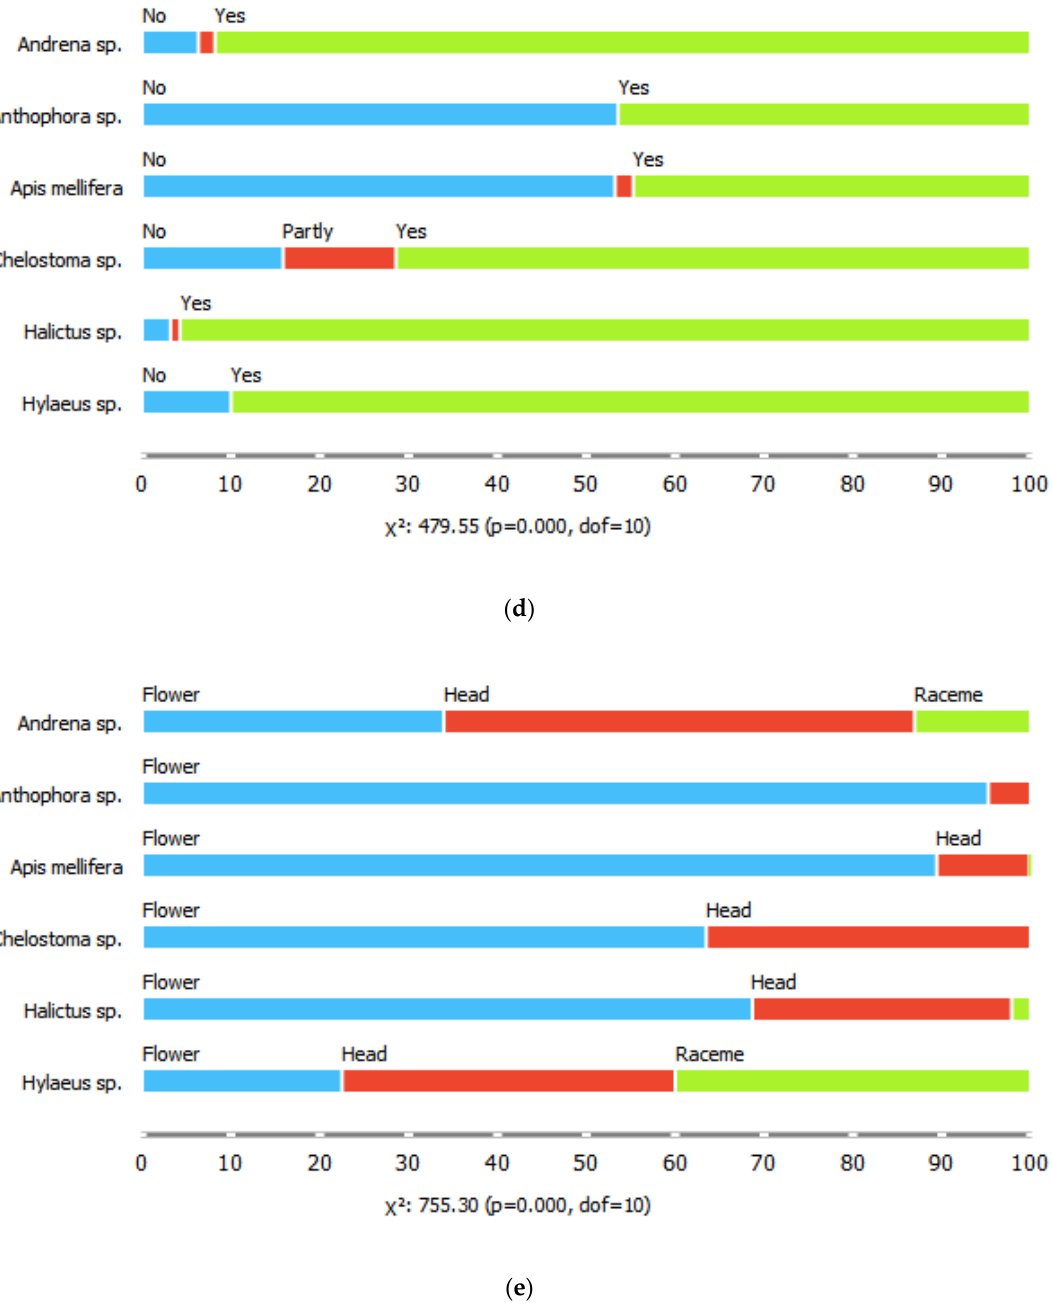
Figure 2. Proportions of ( a ) flower shape classes, ( b ) tube depths, ( c ) symmetry patterns, ( d ) flower segmentation classes, and ( e ) reproductive unit types visited by the six bee